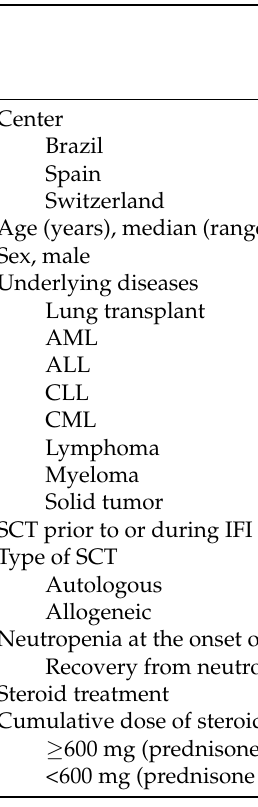
Table 1. Patient characteristics, treatment and